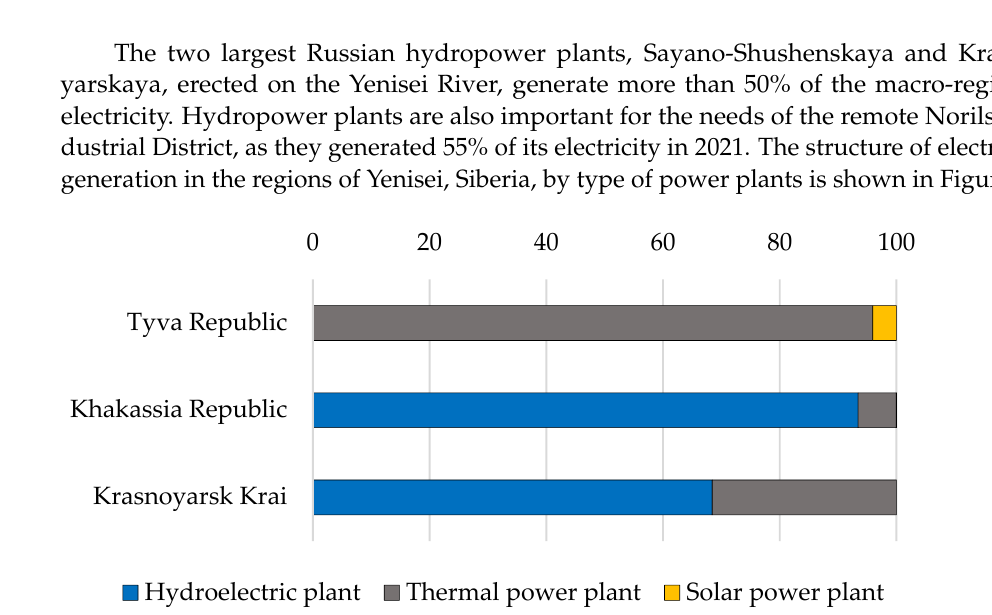
Figure 1. Electricity generation in Yenisei, Siberia, by type of power plant in 2021, %. Source: Rosstat data.